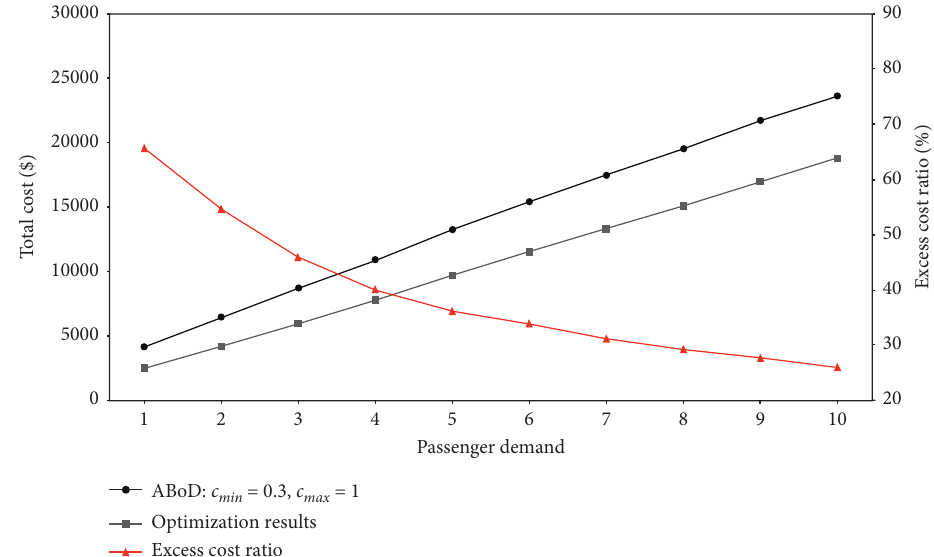
Figure 9: The total cost comparison between ABoD and optimization